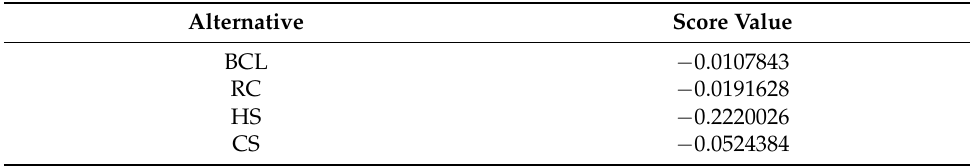
Table 5. Score values of aggregated IVLDF information.